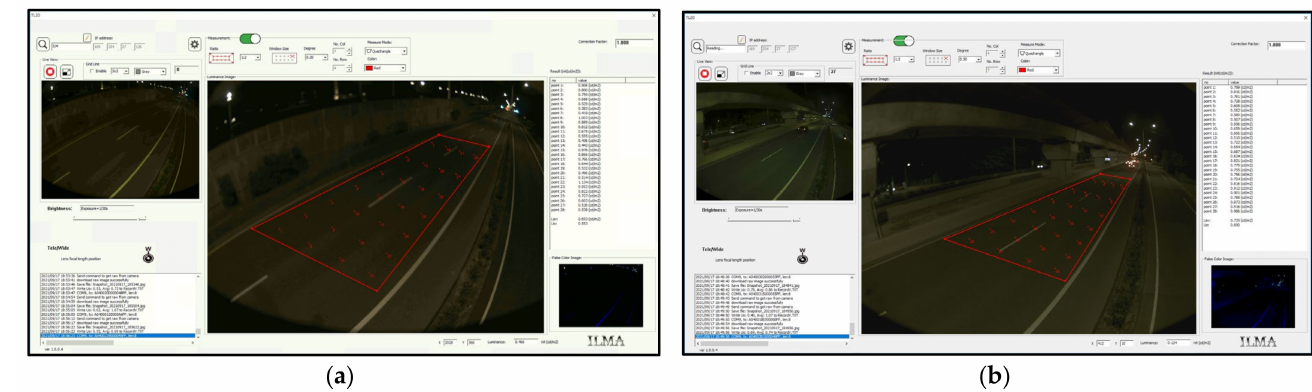
Figure 19. Observation results of the imaging luminance meter: ( a ) Sect. 3 of Gaotie South Road; ( b ) Sect. 5 of Gaotie South Road.